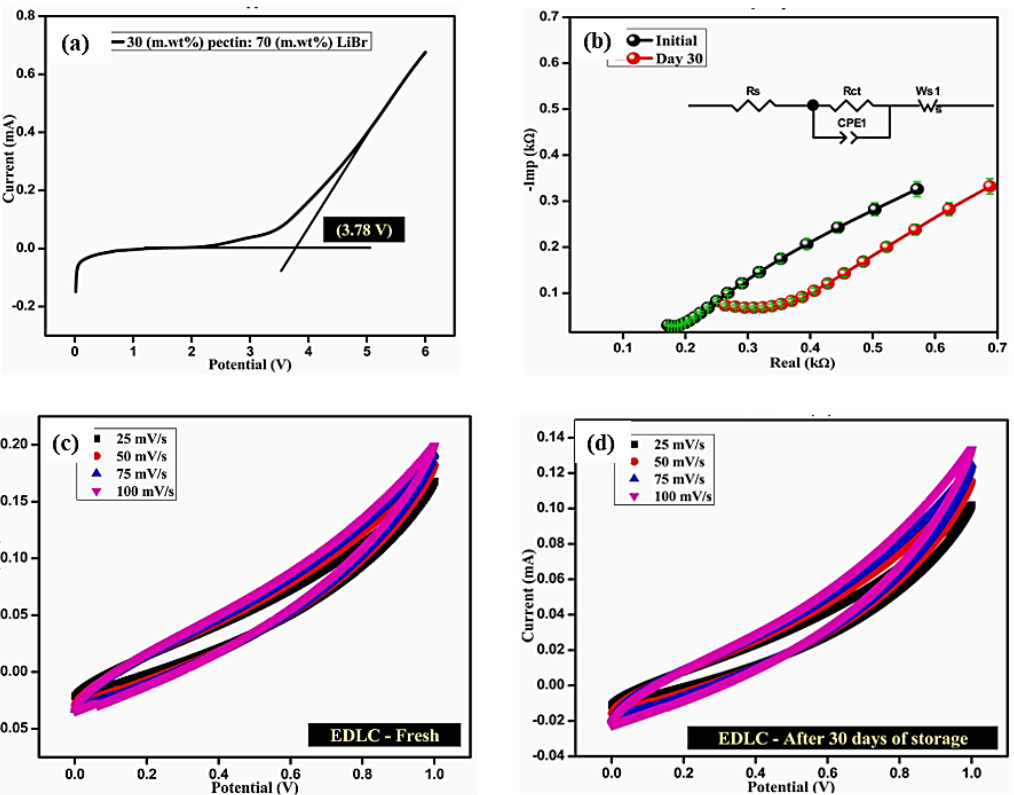
Figure 10. ( a ) LSV plot for Li + complex, ( b ) impedance plots for EDLC before and after storage, fabricated solid-state EDLC CV plot using highest pectin electrolyte ( c ) fresh-Day 1 ( d ) after the storage-Day 30. Adapted from reference [66]. This article is an open-access article distributed